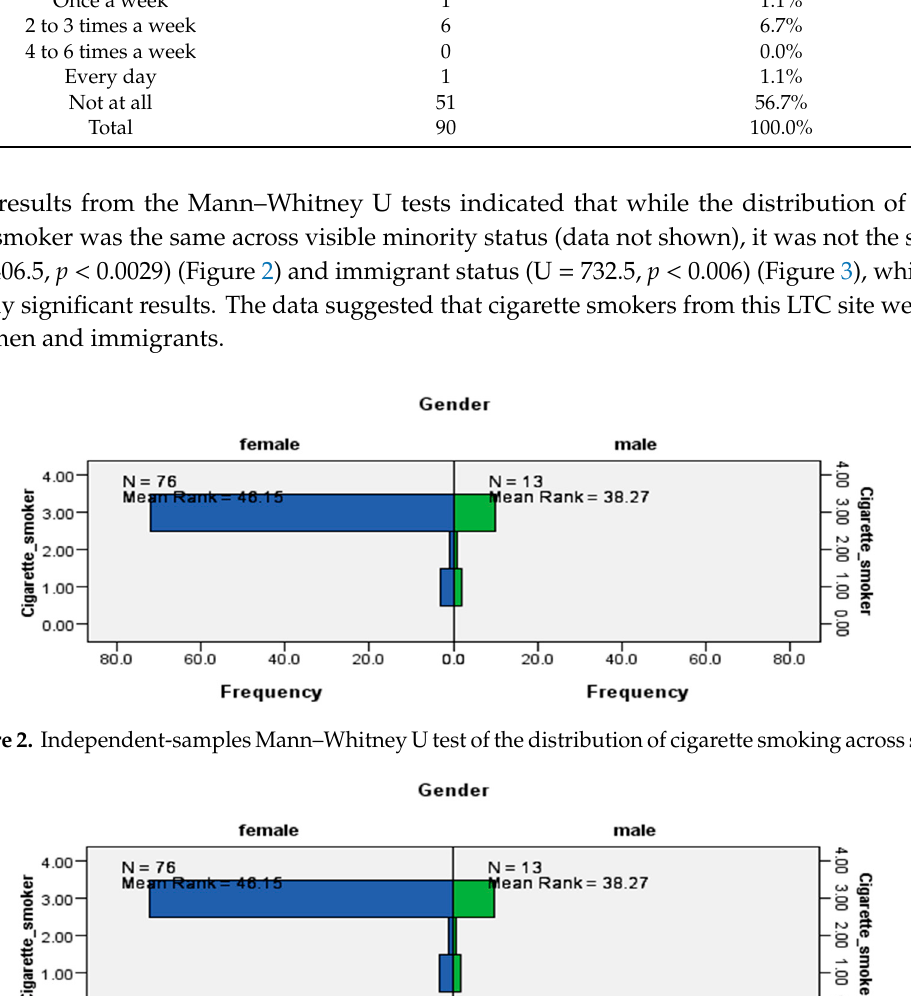
Figure 3. Independent-samples Mann–Whitney U test of the distribution of cigarette smoking across immigrant status.